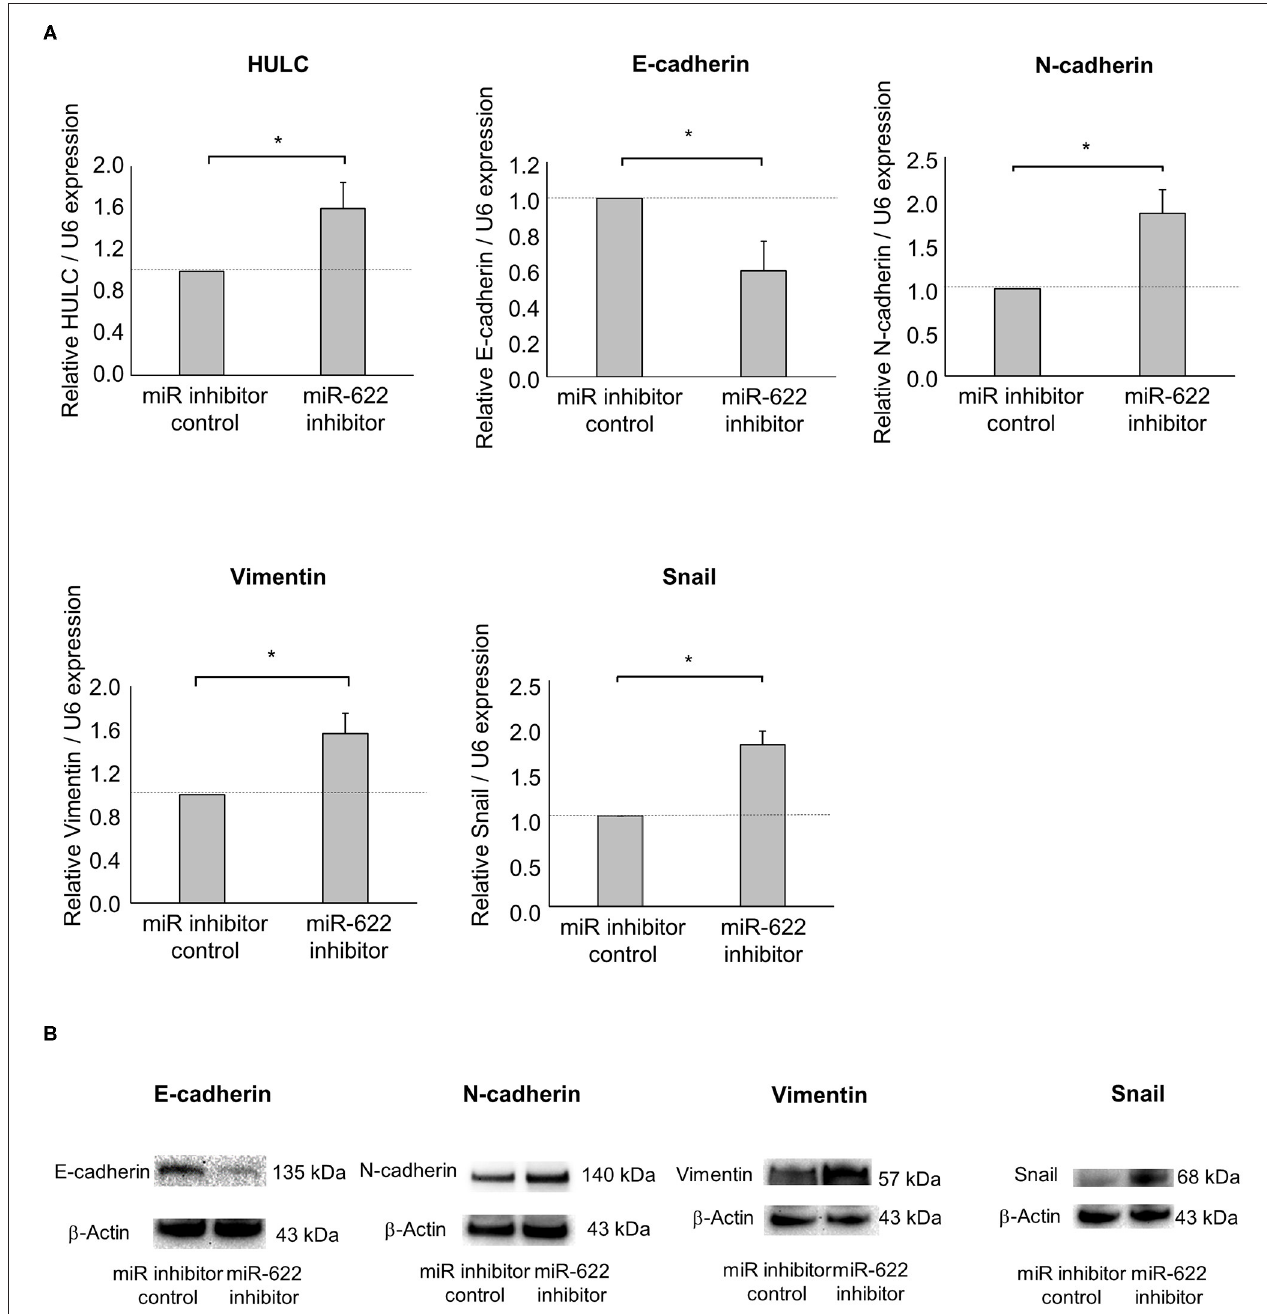
FIGURE 4 | Effect of miR-622 inhibition on EMT in PDAC cells. Panc-1 cells were transfected with 12.5nM miR-622 or a control inhibitor. (A) After 48h, RNA was extracted and expression of HULC, E-cadherin, N-cadherin, vimentin, and Snail was analyzed by qRT-PCR. Bars are the means ± SEM of three independent experiments. * P < 0.05. (B) After 72h, protein was extracted, and western blotting for E-cadherin, N-adherin, vimentin, and Snail was performed. Protein levels were normalized to that of β -actin.